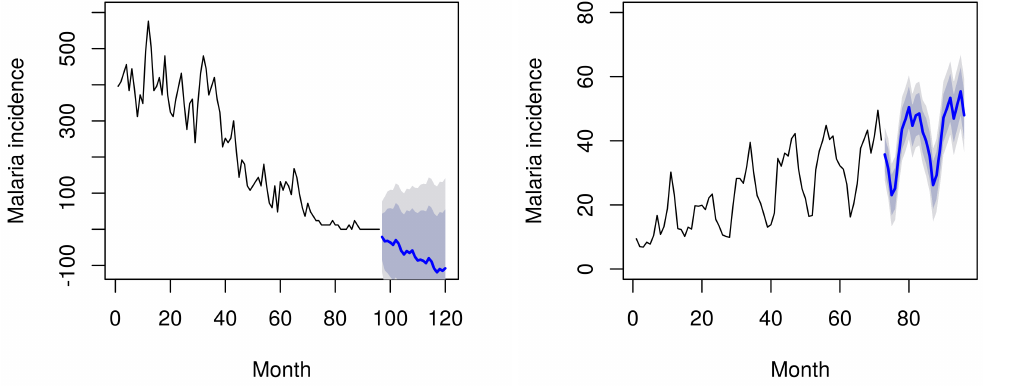
Figure 7. Model simulation (black) and SARIMA model forecasting (blue) of the model simulation at the phase transition: ( a ) low human-to-mosquito transmission efficiency ( w h = 0.420); ( b ) high human-to-mosquito transmission efficiency ( w h = 0.733).